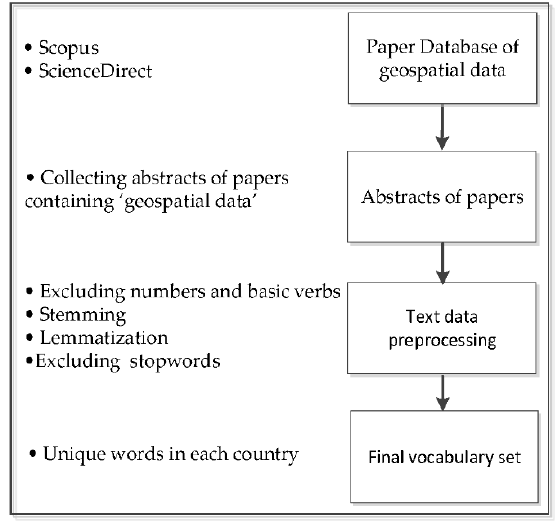
Figure 1. Process of data collection and pre-processing.